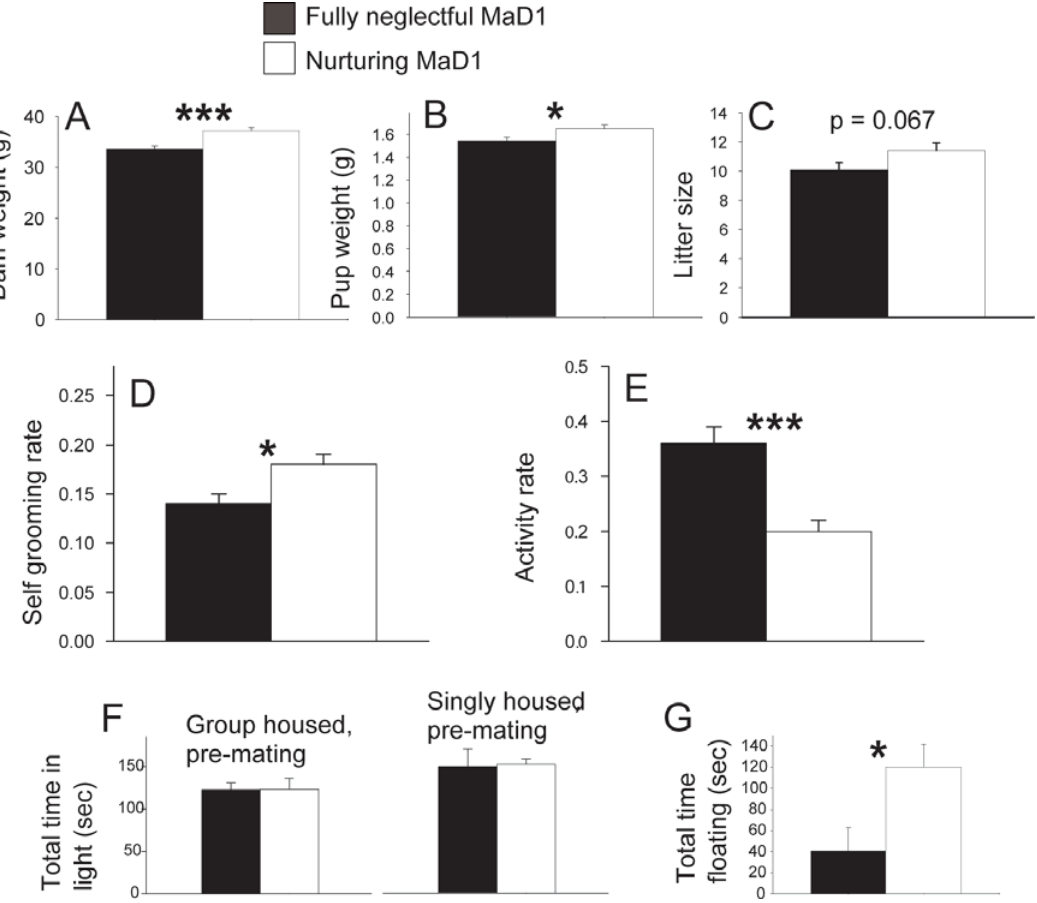
Figure 2. Possible risk factors for maternal neglect in MaD1 mice across multiple generations. When examined for the first litter in on postpartum Day 0, neglectful MaD1 mice weighed significantly less relative to their nurturing sisters (A) and average pup weight was significantly lower for pups born to neglectful mothers (B). Litter size was smaller for neglectful mice, but levels did not reach significance(C). Prior to mating, decreases in self-grooming (D) and increases in activity (E) were seen in neglectful relative to nurturing mice (D). For A–C, data from Generations (G) 12 and 15 were combined and for D and E, data from G6, G12, and G15 were combined. Time in light in a light/dark box test, did not differ between mice that would become either neglectful or nurturing when examined in G15 (F). Mice were first examined for anxiety at age 50 when they were group housed and then again after being singly housed for one week. In G17, neglectful mice spent significantly less time floating in the forced swim test relative to nurturing mice (G). Bars represent means 6 SE. * =p , 0.05; *** =p ,